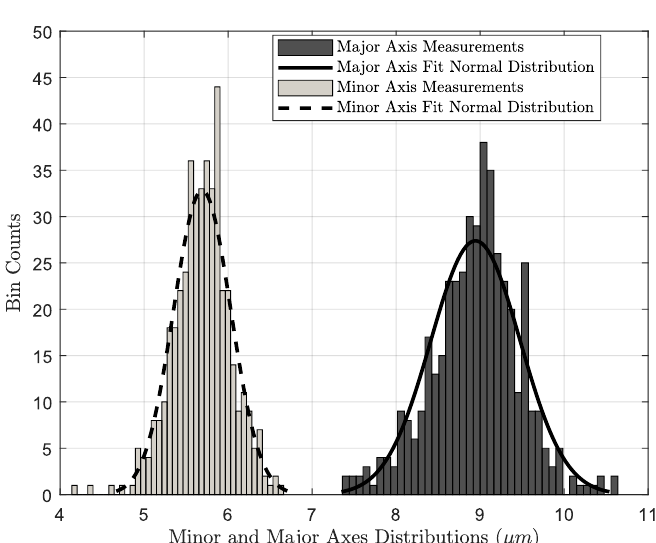
Figure 8. Ellipses fit to several fibers.